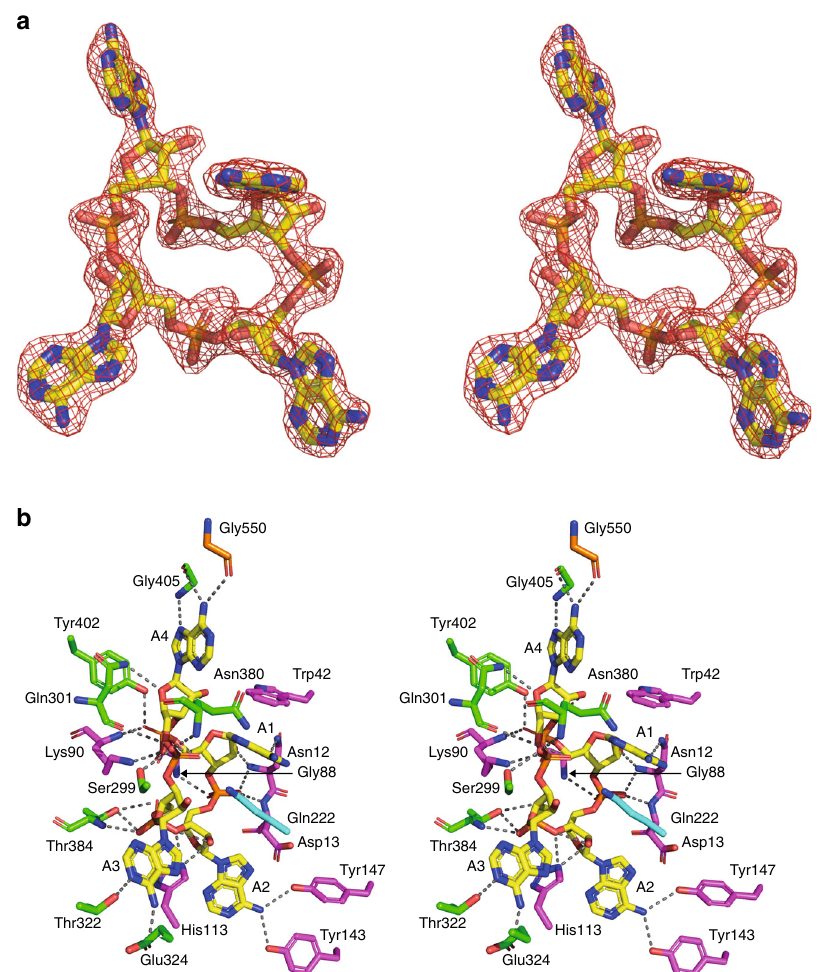
Fig. 2 Structure of the cA 4 activator and interactions with Can1. a Divergent stereo representation of cA 4 (in stick representation; carbon in yellow, nitrogen in blue, oxygen in red) with the maximum likelihood/ σ A weighted F obs — F calc electron density map contoured at 3.0 sigma shown in red. b Divergent stereo representation of the binding site of cA 4 in complex with Can1. cA 4 (with each AMP numbered A1-A4) and binding site residues are shown in stick representation, with cA 4 in yellow and amino acid residues coloured by the domain from which they originate (CARF domain 1: magenta, domain 2/nuclease-like domain: cyan, CARF domain 2: green, nuclease domain: orange). The dotted lines represent hydrogen bond interactions.